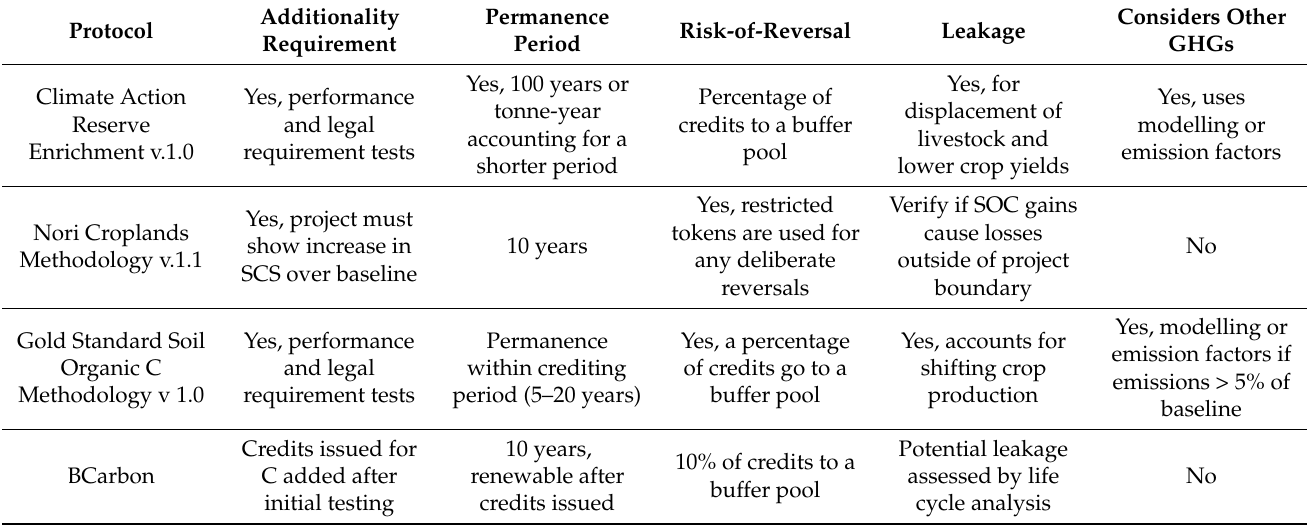
Table 1. Examples of protocols for soil carbon sequestration recognized in the